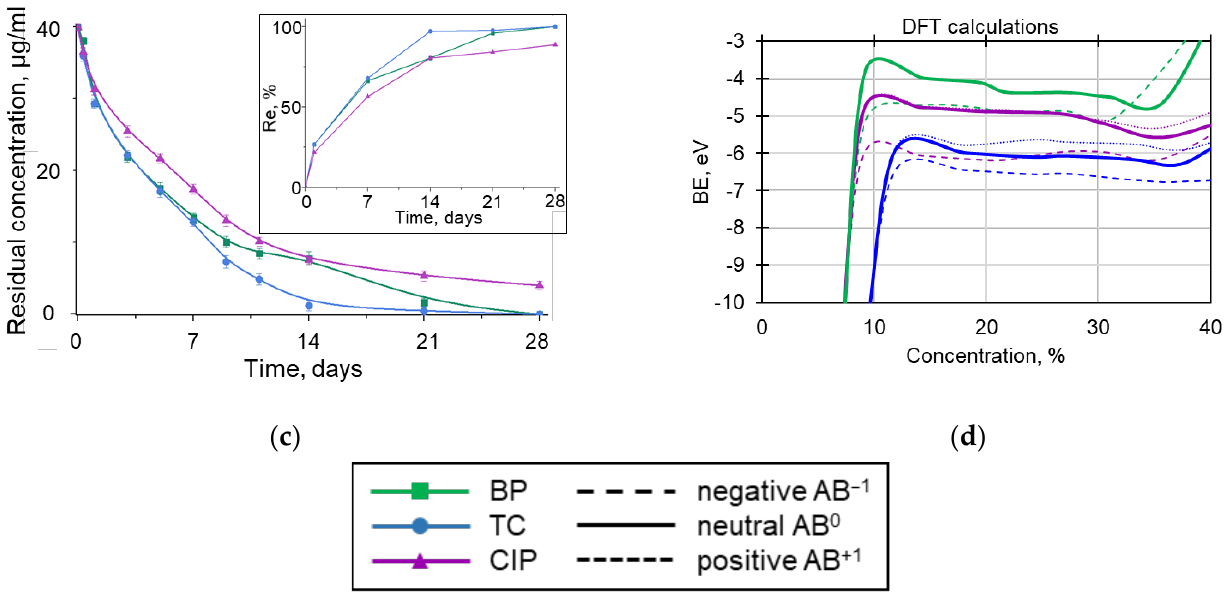
Figure 5. Kinetics of antibiotic adsorption by BNNPs at initial antibiotic concentrations of 10 ( a ), 20 ( b ), and 40 µg/mL ( c ). The studies were carried out at T = 24 °C and pH 6. Insets show the dependence of antibiotic removal efficiency versus time. ( d ) DFT calculation of antibiotic sorption. BP — benzylpenicillin, TC — tetracycline, CIP — ciprofloxacin.